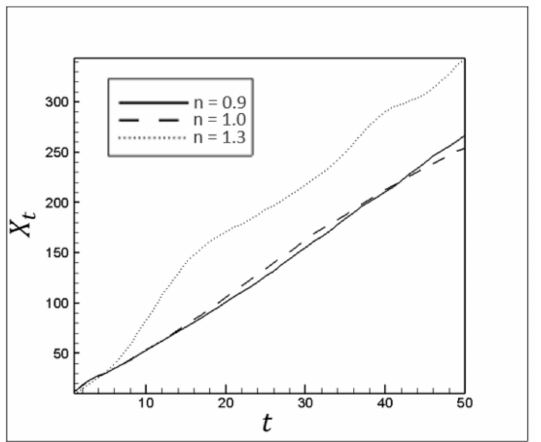
Figure 14. The invading fluid front at the top of the channel, X t , over time for different n.